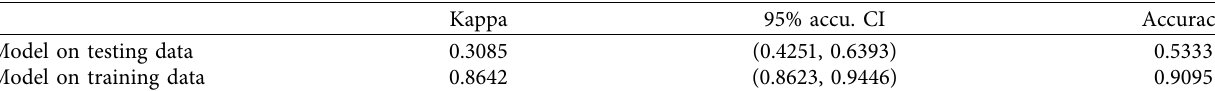
Table 5: Prediction comparison with testing on training